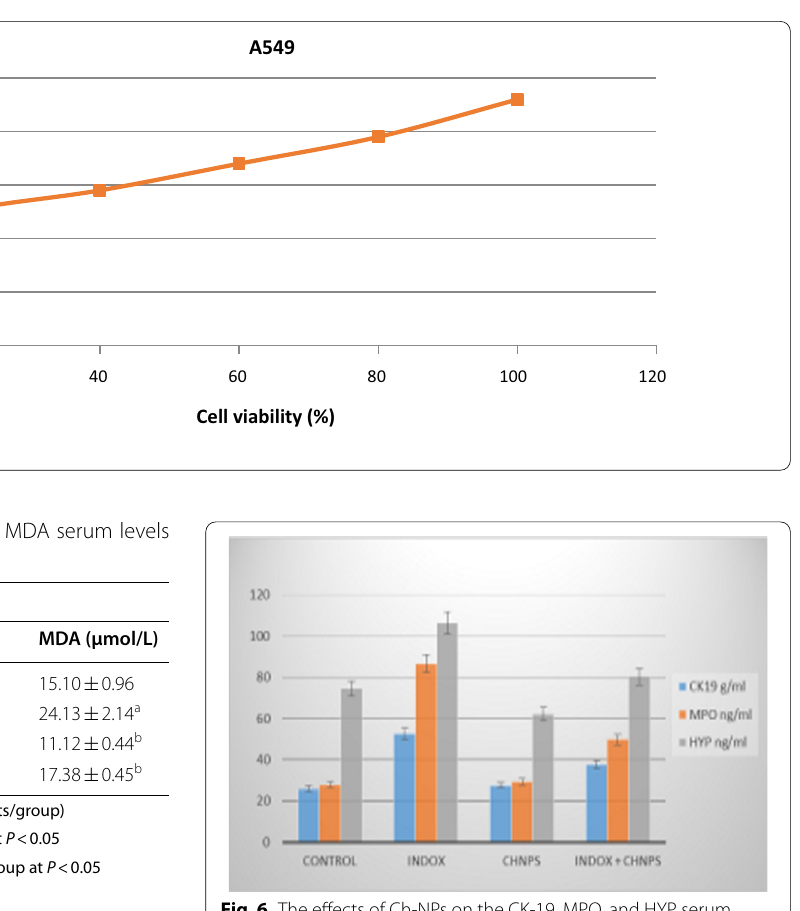
Fig. 6 The effects of Ch-NPs on the CK-19, MPO, and HYP serum levels in rats administered